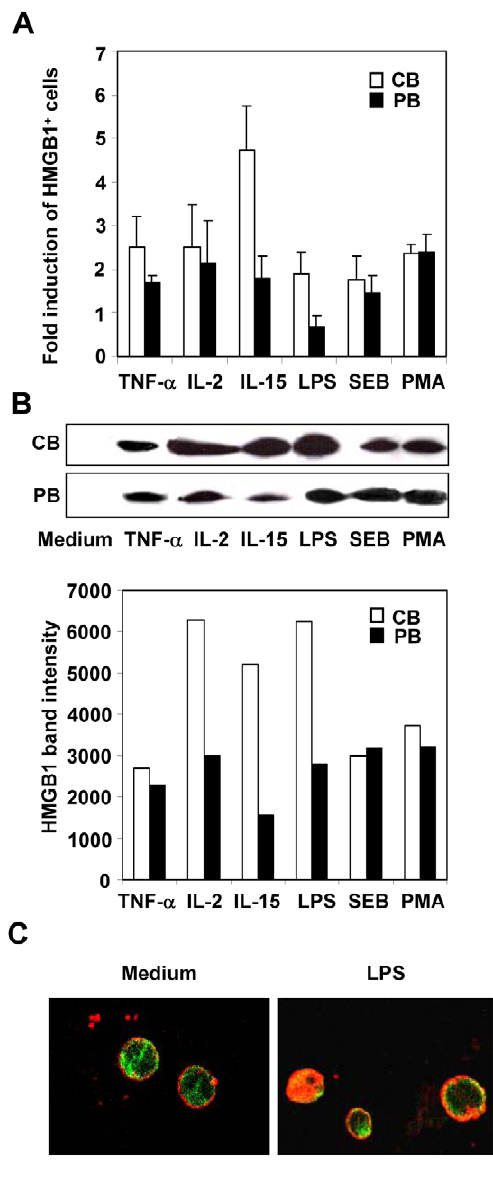
Figure 4. Different stimuli induce cell surface-expressed HMGB-1 and its secretion into extracellular environment. Various activation signals, such as proinflammatory stimuli (TNF- a or IL-2 or IL-15) or that mimic infection (LPS, SEB or PMA) have been used to influence the cell surface expression and active secretion of HMGB1. CB and PB cells have been treated with proinflammatory mediators for 14 days and stimuli that mimic infection for 48 h. (A) Cell surface expression of HMGB1 has been analyzed by FACS analysis, evaluating the percentage of positive cells. In bar graph the values are shown as ratio between treated and untreated cells expressing HMGB1 (fold induction). The values are the mean 6 SD of four experiments from different donors. (B) The culture medium of CB or PB cells, which have been analyzed in (A) for surface HMGB1 expression, has been evaluated for its secretion by western blot analysis. The levels of protein shown in (B), quantified by densitometric analysis, has been expressed as arbitrary units. Western blot are representative of three independent experiments. (C) Untreated CB cells or treated with LPS for 48 h were fixed, permeabilized and stained with anti-HMGB1 antibody (green channel) and membrane-specific PKH26 red fluorescent dye. The fluorescence has been analyzed by confocal microscopy (Leica TCS